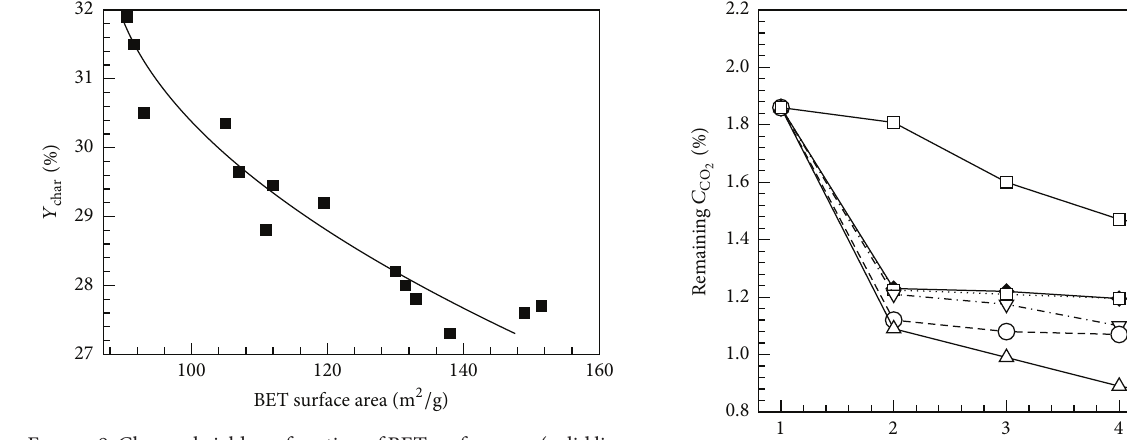
Figure 9: Charcoal yield as a function of BET surface area (solid line denotes fitted trend).